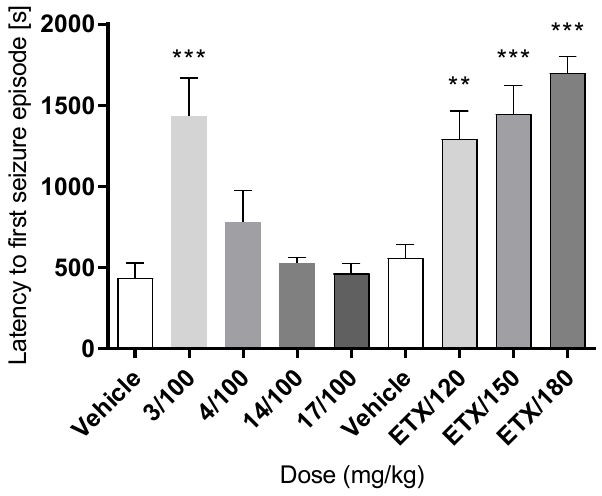
Figure 2. Anticonvulsant activity of compounds 3 , 4 , 14 , 17 , and ethosuximide (ETX) in the sc PTZ test. Each value represents the mean ± S.E.M. obtained from 4–6 mice. Statistical analysis: one-way analysis of variance (ANOVA), followed by Dunnett’s post hoc test. Significant difference compared to the control group: ** p < 0.01, *** p < 0.001. Data for ETX from the previous study [24].